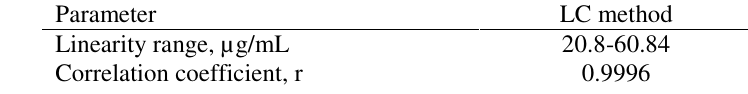
Figure 1 . System precision chromatogram. Table 2. Regression analysis of the calibration curves for donepezil hydrochloride by the proposed LC method.